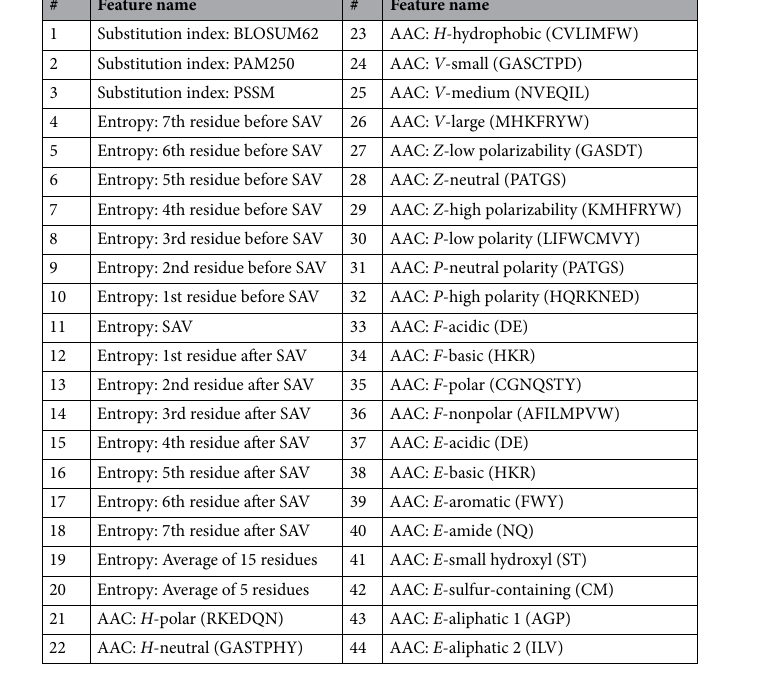
Table 2. List of descriptors in the sequence-based feature set.